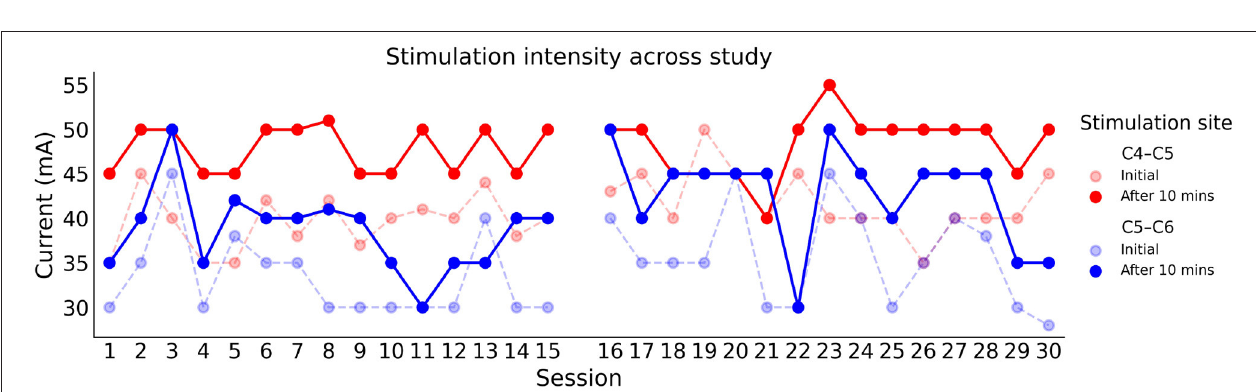
FIGURE 6 | Stimulation intensity used in each training session across the study. The rostral (C4–C5) and caudal (C5–C6) electrodes are represented with red and blue respectively. The faded traces indicate the initial current intensity before